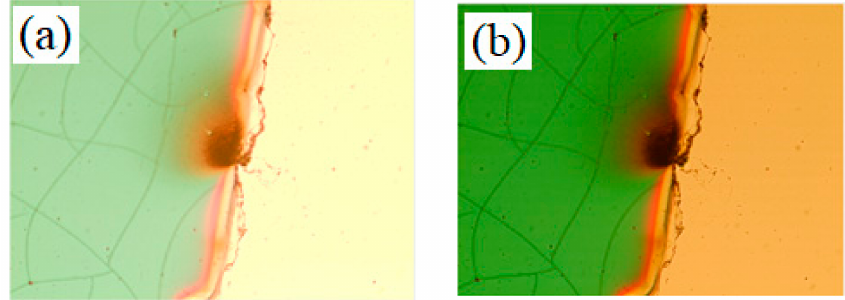
Figure 9. Microscopic images of ( a ) original image without filter; ( b ) using 480 nm notch